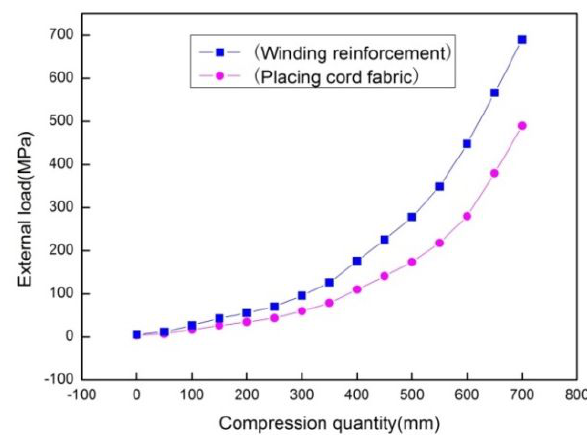
Figure 17: The relationship between amount of compression and external